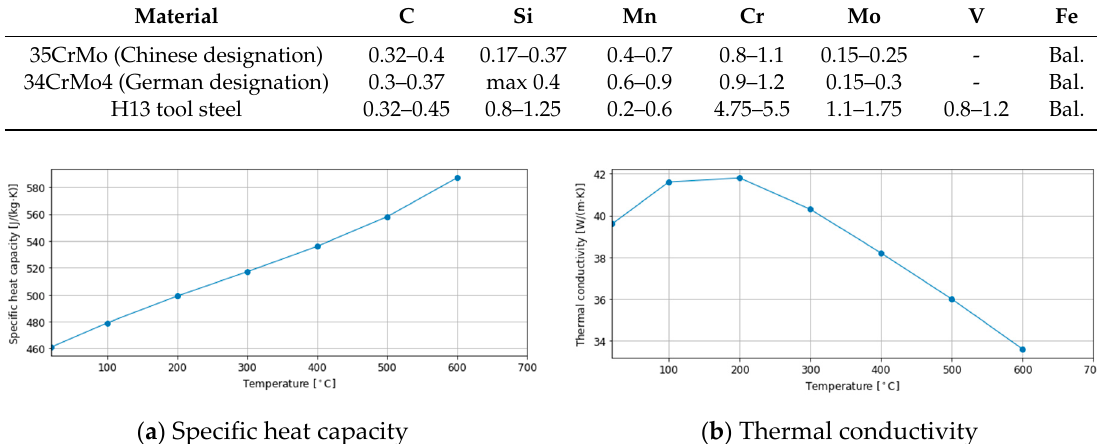
Figure 4. Temperature-dependent thermophysical properties of 34CrMo4 (German designation). Table 2. Chemical composition of 35CrMo, 34CrMo4 and H13.